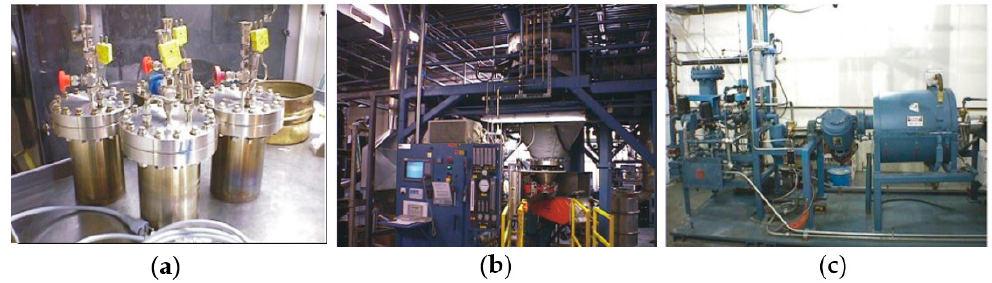
Figure 10. Images of ( a ) a 2-kg stationary, ( b ) a 3-ton stationary, and ( c ) a 20-kg rotational hydrogen